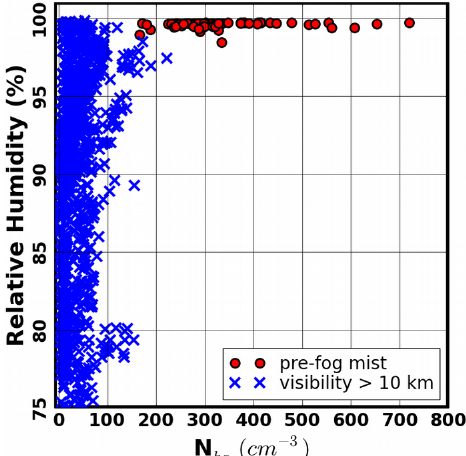
Figure 9. Correlation between relative humidity measured at 2m a.g.l. and the hydrated aerosol number concentration for two regimes: visibility > 10km and pre-fog